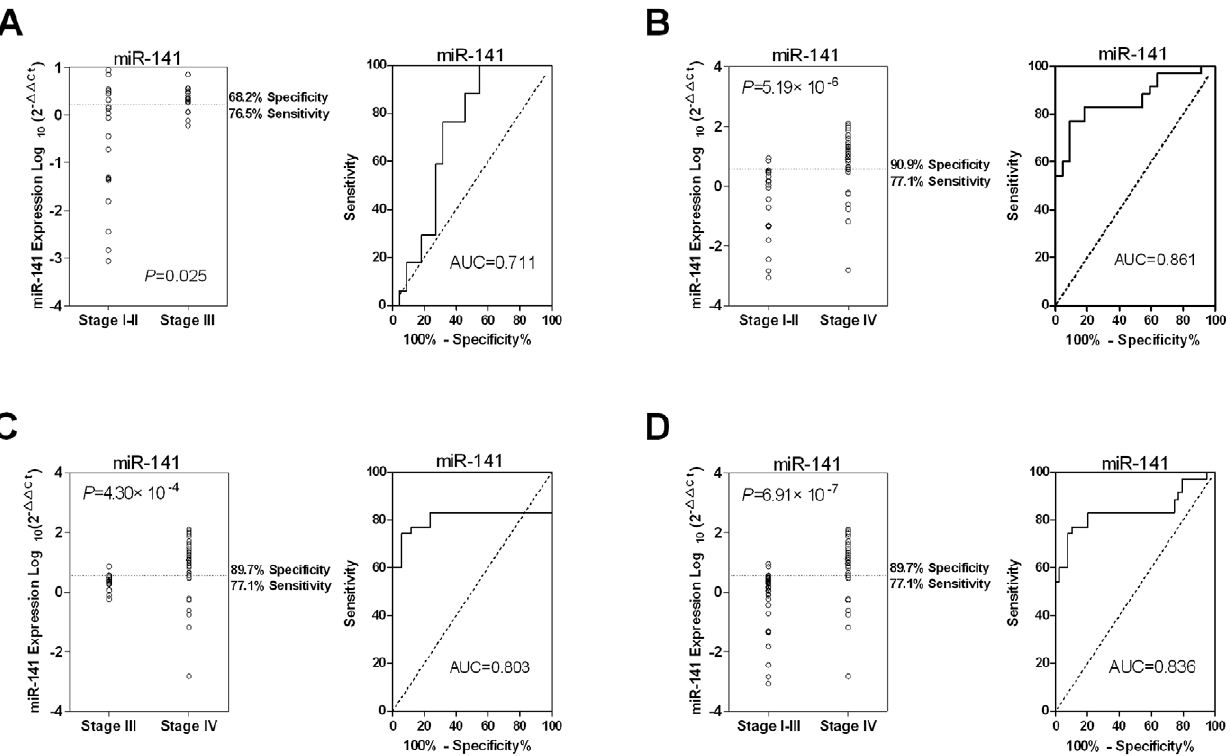
Figure 2. Higher plasma miR-141 is significantly associated with Stage IV colon cancer in the training set. (A) Small RNA was isolated from plasma samples and miR-141 was measured by quantitative RT-PCR assays. The Wilcoxon two-sample test was performed to evaluate differences of miR-141 levels between the Stage III and Stage I–II groups. ROC analysis was performed to determine the sensitivity and specificity with the value of AUC in the right panel. The Wilcoxon two-sample tests between (B) Stage IV and Stage I–II, (C) Stage IV and Sage III, and (D) Stage IV and Stage I–III groups were performed to evaluate the association of plasma miR-141 with Stage IV disease status.